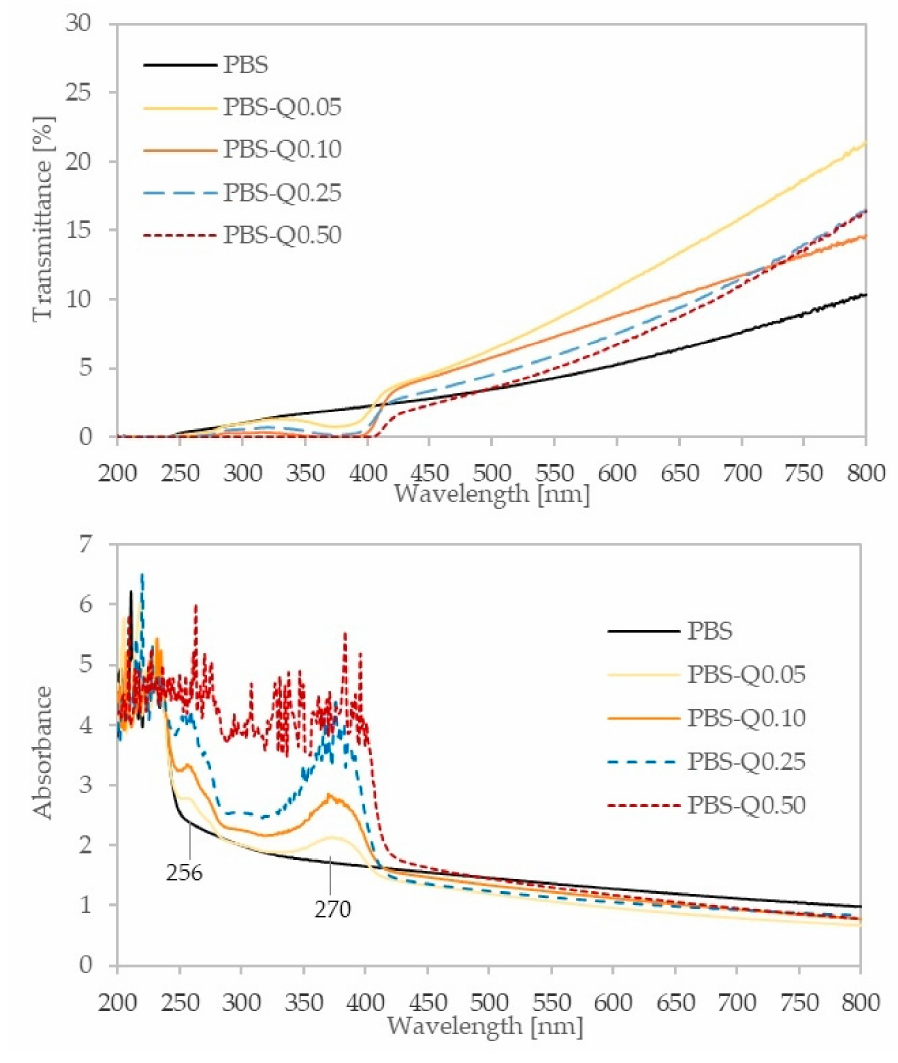
Figure 3. UV–vis spectra of PBS-based neat and modified